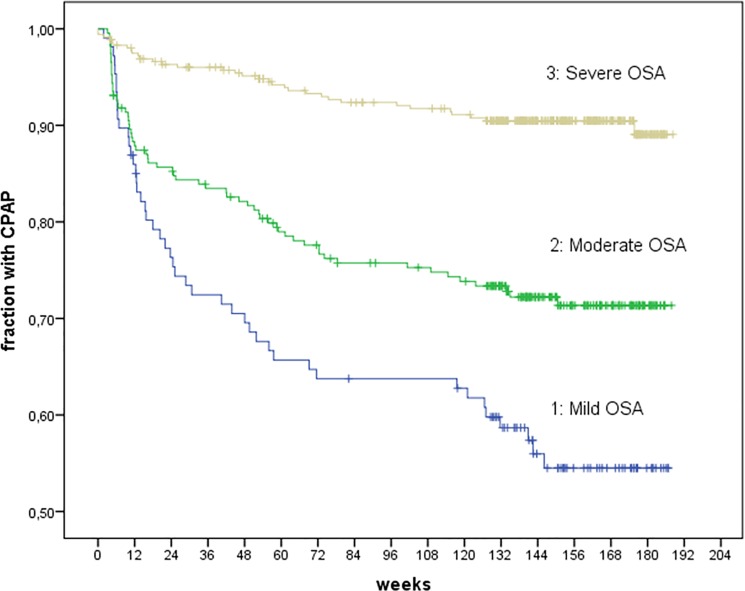
Kaplan-Meier plot.Kaplan-Meier plot showing the fraction of patients adherent to CPAP therapy for three strata of AHI; mild, moderate and severe OSA.